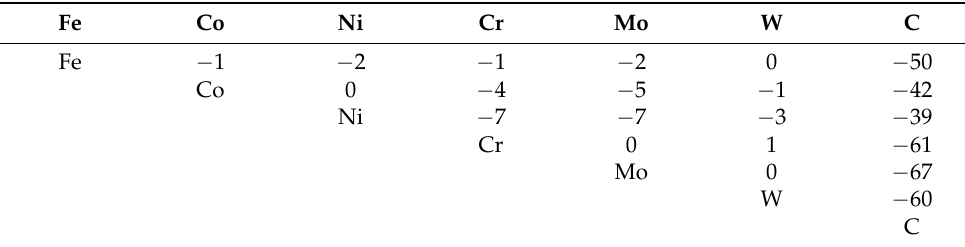
Table 4. Enthalpy of mixing between elements (KJ · mol − 1